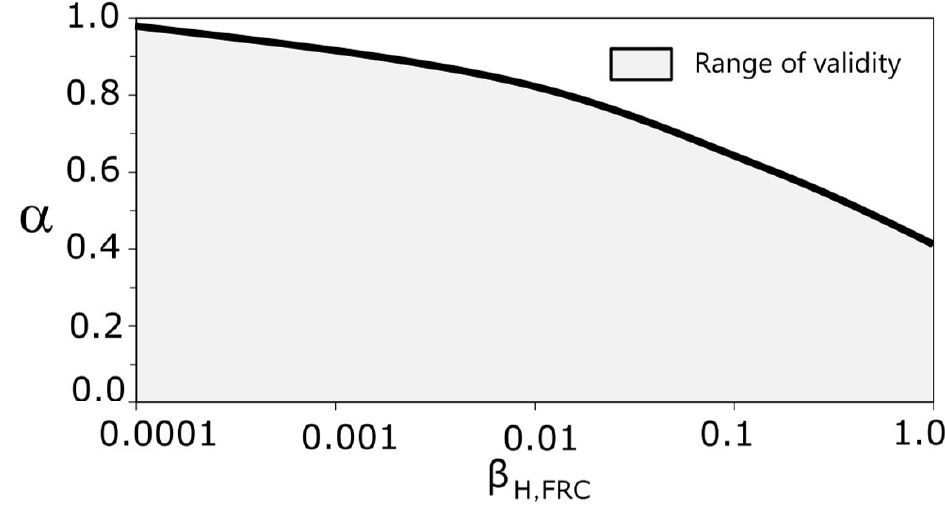
Figure 12. Validity range for the proposed formulation.